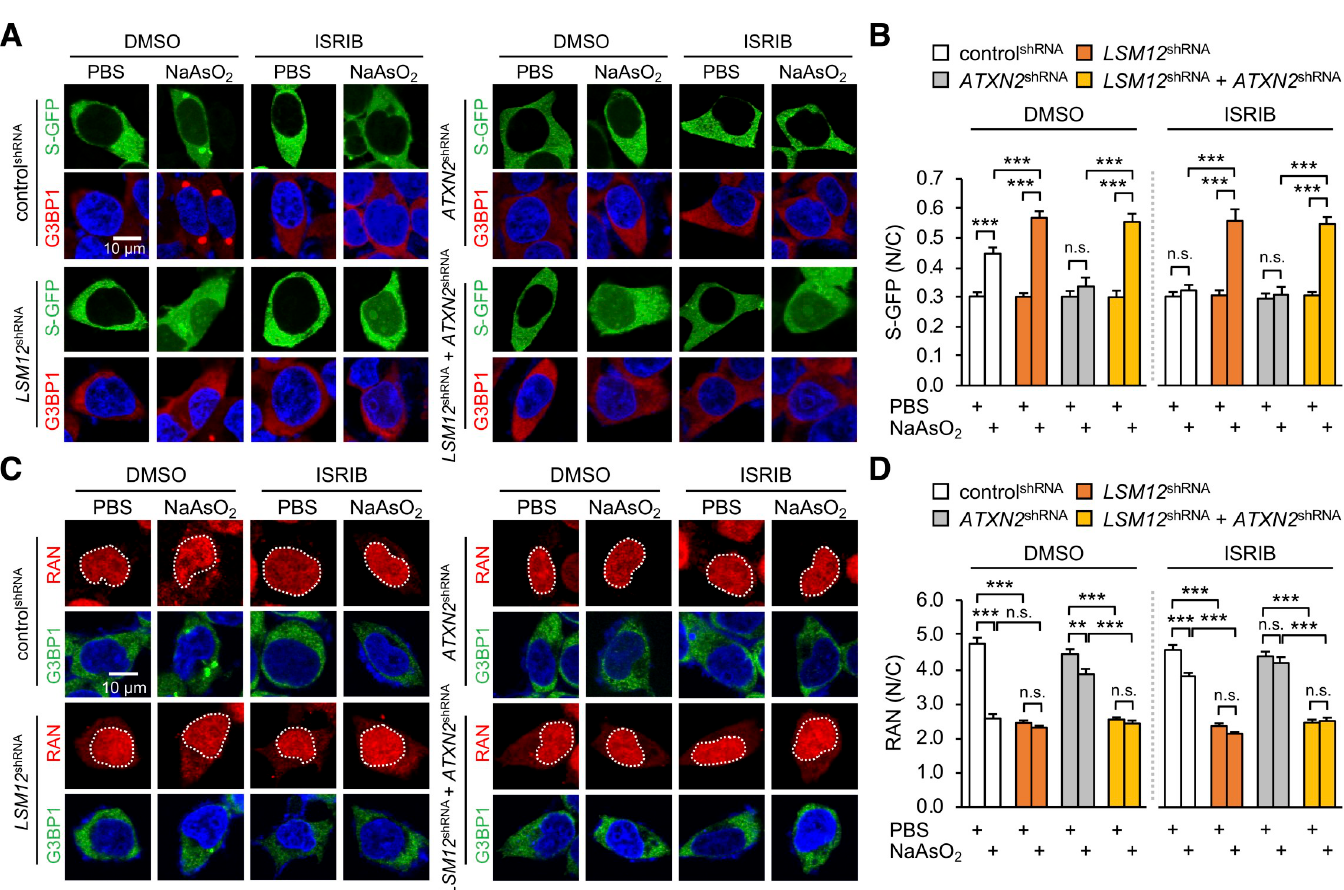
Fig 2. LSM12 depletion disrupts the RAN gradient and impairs NCT upon oxidative stress. (A) LSM12 depletion impairs NCT under oxidative stress conditions in a manner that is independent of ATXN2 or SG assembly. Individual shRNA cell lines were transfected with an expression vector for the S-GFP reporter. SG assembly was then quantified 48 hours after transfection. Transfected cells were co-stained with anti-G3BP1 antibody (red) and Hoechst 33258 (blue). Where indicated, cells were incubated with 50- μ M NaAsO 2 or PBS (vehicle control) for 2 hours to induce oxidative stress. Phospho-EIF2 α –dependent SG assembly was blocked by treating with 2- μ M ISRIB for 3 hours before NaAsO 2 incubation. DMSO was used as vehicle control for ISRIB. (B) NCT of S-GFP reporter proteins was quantified by calculating the ratio of N/C fluorescence in individual cells. Two-way ANOVA detected significant interaction effects of arsenite and ISRIB treatments on NCT only in control shRNA cells ( P = 0.0004). Data represent means ± SEM ( n = 100–137 cells from 3 independent experiments). n.s., not significant; ��� P < 0.001, as determined by Tukey post hoc test. (C) LSM12 depletion disrupts the nucleocytoplasmic RAN gradient in a manner that is independent of ATXN2 or SG assembly. Cells were incubated with 2- μ M ISRIB, 50- μ M NaAsO 2 , or vehicle controls as described above and then co-stained with anti-RAN antibody (red), anti-G3BP1 antibody (green), and Hoechst 33258 (blue). (D) The relative distribution of endogenous RAN proteins was quantified by calculating the ratio of N/C fluorescence. Two-way ANOVA detected significant interaction effects of arsenite and ISRIB treatments on the RAN gradient only in control shRNA cells ( P < 0.0001). Data represent means ± SEM ( n = 95–104 cells from 3 independent experiments). n.s., not significant; �� P < 0.01, ��� P < 0.001, as determined by Tukey post hoc test. All underlying numerical values are available in S1 Data. ANOVA, analysis of variance; ATXN2, ataxin-2; GFP, green fluorescent protein; ISRIB, integrated stress response inhibitor; LSM12, like-Sm protein 12; N/C, nuclear to cytoplasmic; NCT, nucleocytoplasmic transport; SEM, standard error of the mean; SG, stress granule; shRNA, short hairpin.